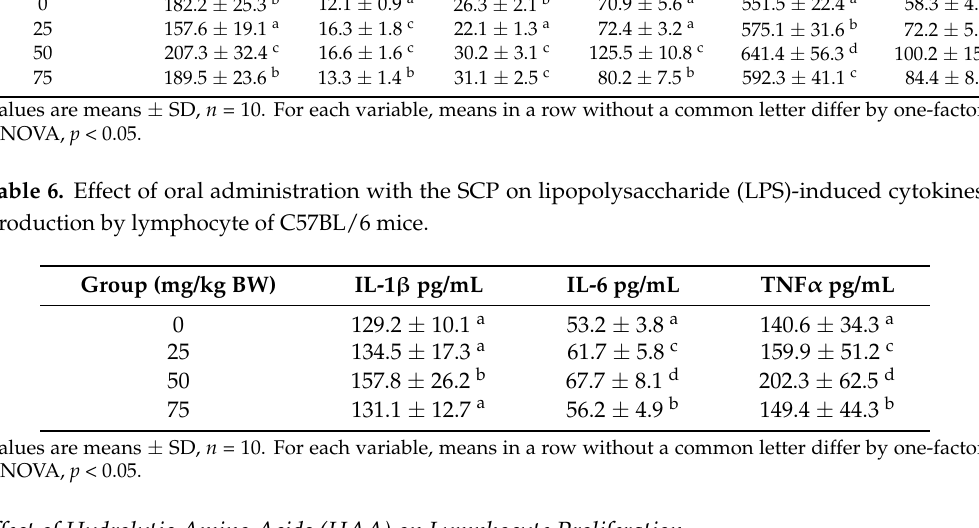
Table 5. Effect of oral administration with the SCP on Concanavalin A (Con A)-induced cytokines production by lymphocyte of C57BL/6 mice.